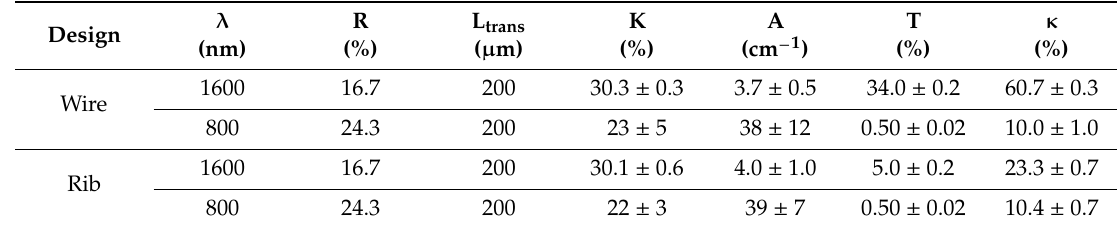
Table 1. Measured linear optical